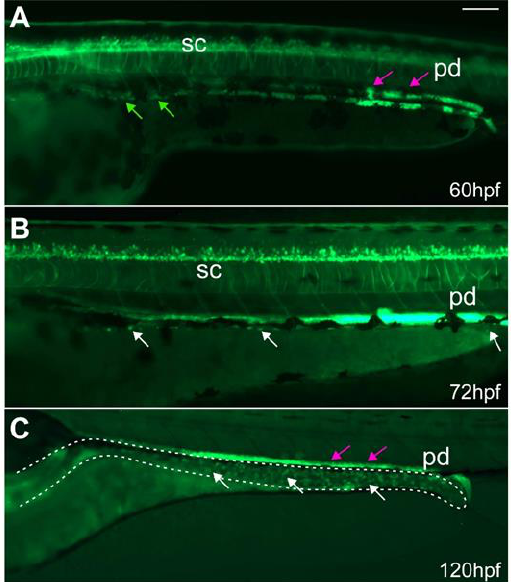
Figure 2. ret:GFP + EPCs migrate along the developing gut and populate the gut. At ( A ) 60 hpf, GFP + EPCs (green arrows) migrate along the developing gut. At ( B ) 72 and ( C ) 120 hpf, GFP + ENS cells (white arrows) populate the gut (dashed line). Some of the GFP + cells in the gut are enteroendocrine cells. The GFP + pronephric ducts (pd, magenta arrows) directly overlay the ENS. ( A – C ): Whole-mount side-views of embryos/larvae at the stage indicated. Dashed line outlines the gut. Scale bar = 100 µm.